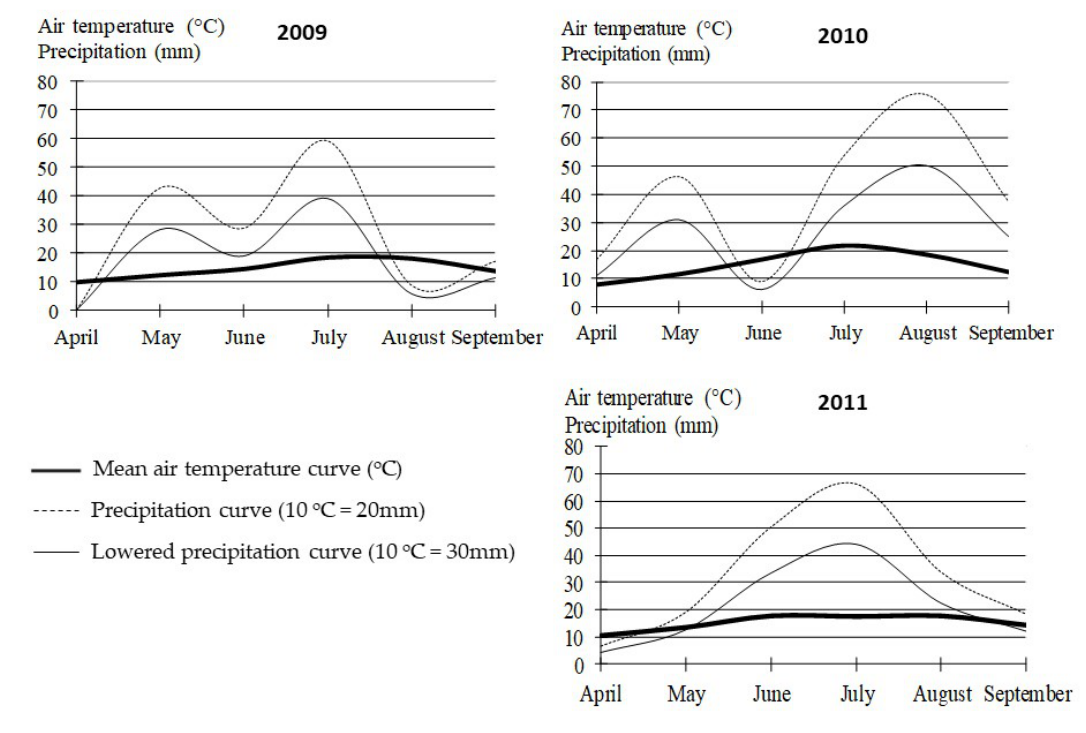
Figure 2. Meteorological conditions in 2009–2011, according to Gregorczyk et al. [31]